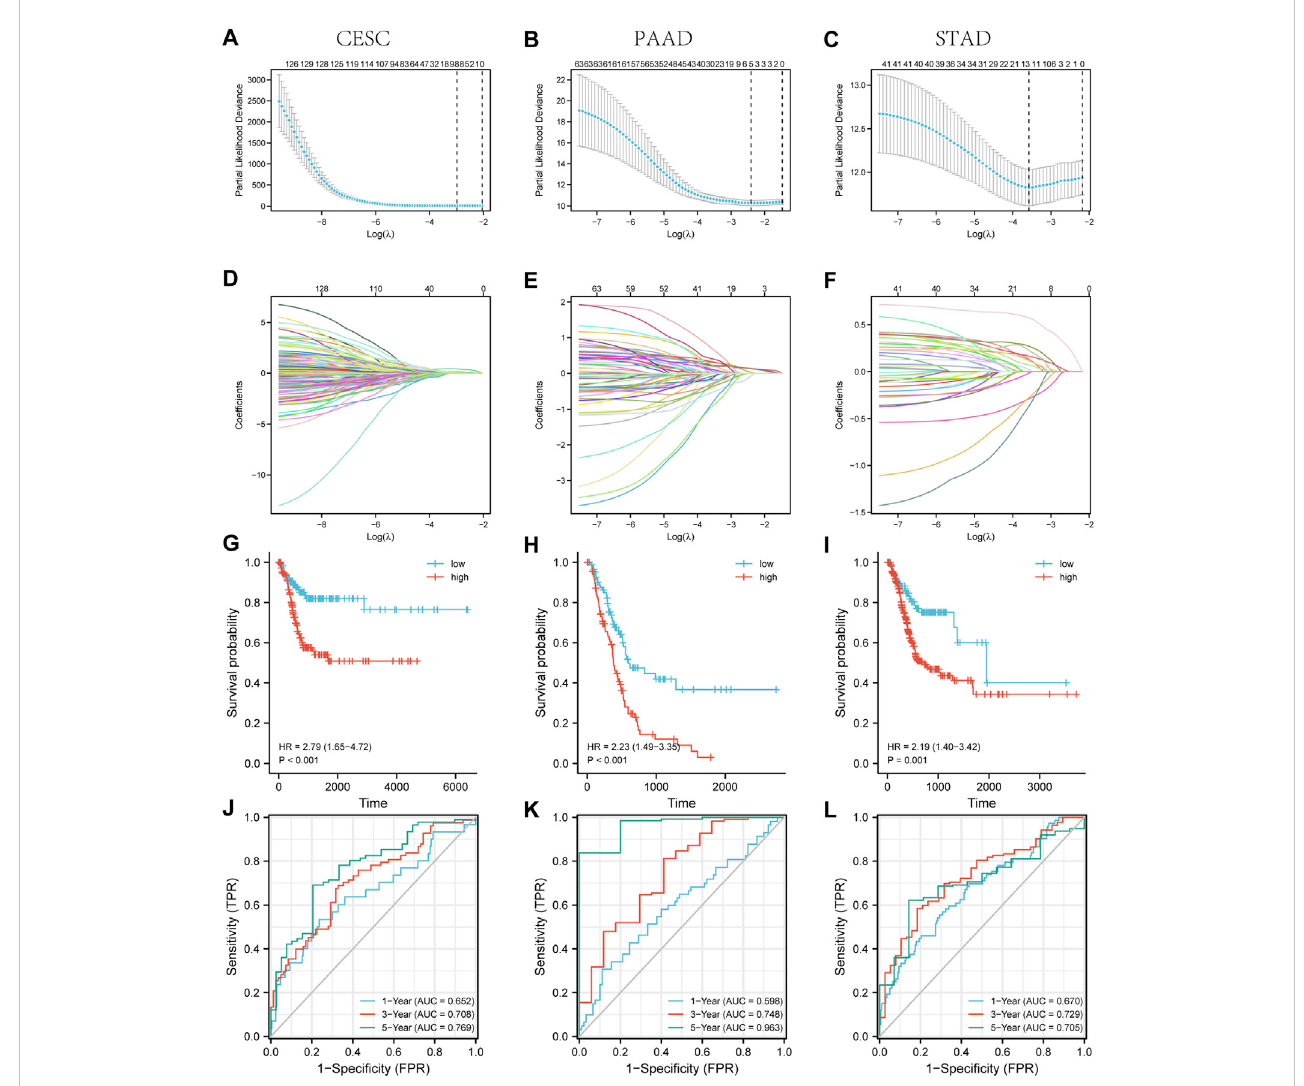
FIGURE 6 Three lncRNA prognostic models associated with ZNF281 showed good accuracy in predicting the prognosis of patients in CESC, PAAD, and STAD. (A – C) Cross validation based on C-index to determine the best choice of genes in the prediction models. (D – F) Genes in the different choices of models and their corresponding coef fi cients based on different lambda values. (G – I) According to prediction models, the relationship between the survival outcome and risk levels of patients. (J – L) The tdROC curve of 1, 3, and 5 years veri fi ed the ef fi cacy of prediction models. (A,D,G,J) CESC, (B,E,H,K) PAAD, and (C,F,I,L)